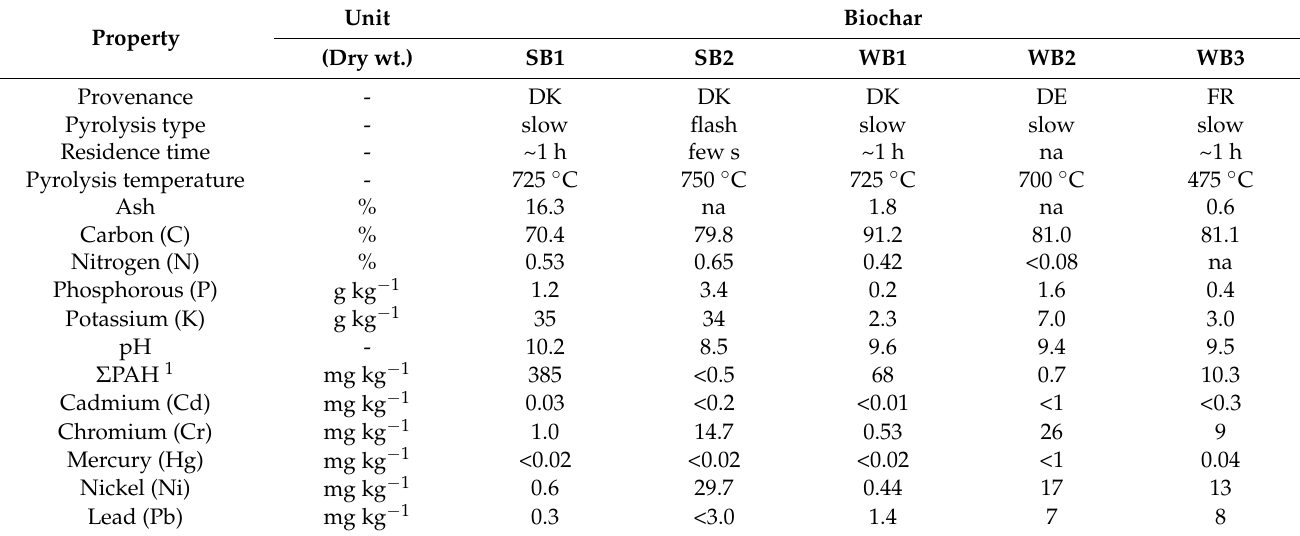
Table 1. Pyrolysis conditions and chemical composition for the five biochars from wheat straw (SB1, SB2), pine wood (WB1, WB2), and oak wood (WB3). Chemical analyses were performed by certified laboratories (WESSLING, Hungary; FORCE Technology, Denmark; AGROLAB, Germany); na—not